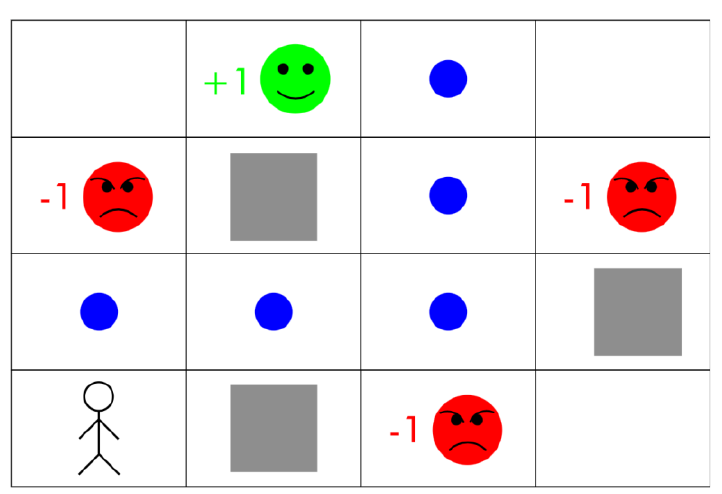
Figure 20. Unsupervised learning — information extraction (Adapted from [29]). Figure 19. Unsupervised learning—information extraction (Adapted from